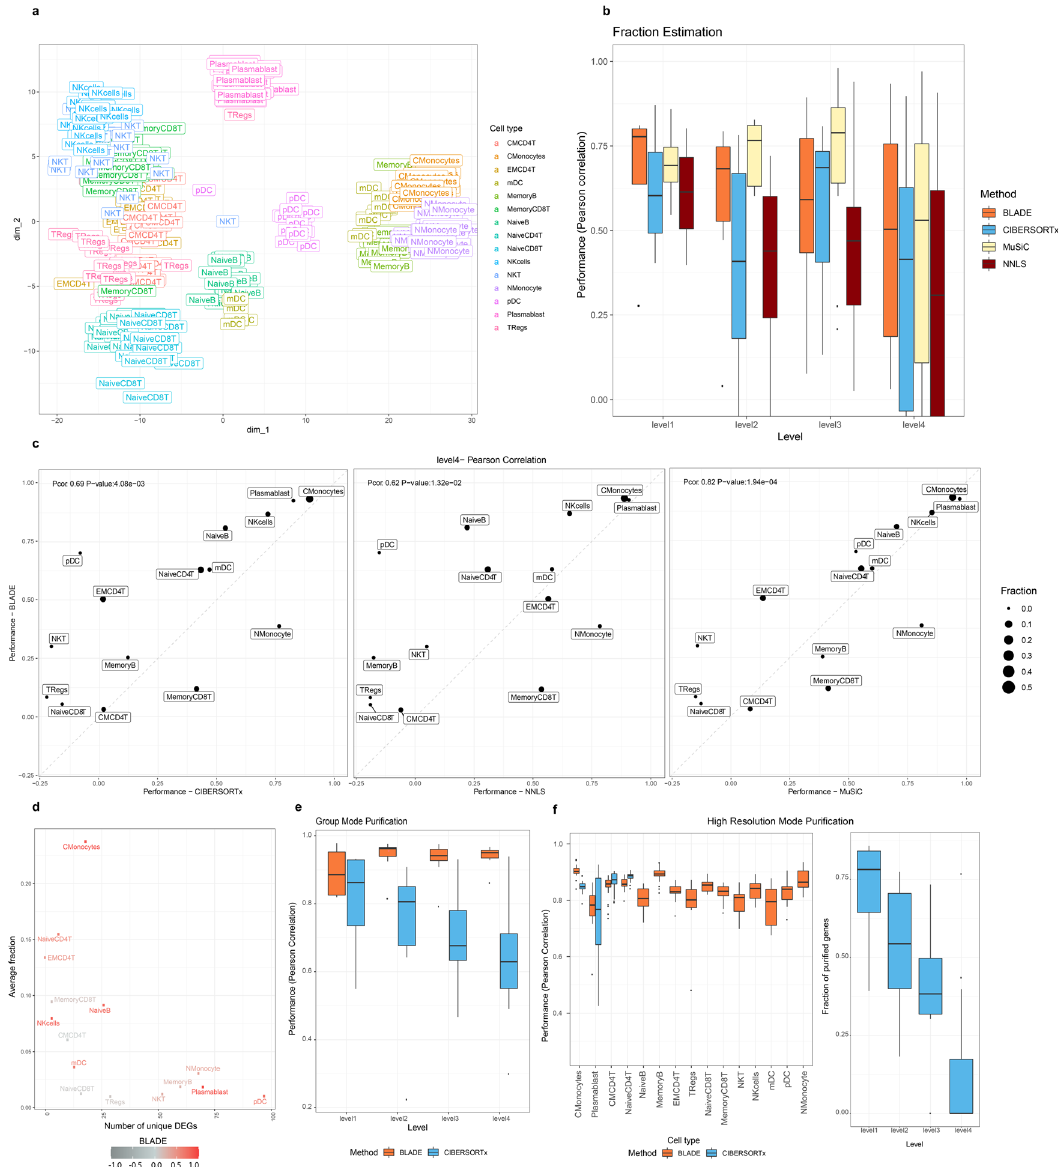
Fig. 5 Performance evaluation of BLADE using simulated PBMC bulk RNA-seq data. a A t-SNE plot represents the similarities in Pearson correlation coef fi cients among gene expression pro fi les of 15 cell types* (denoted by label) in 20 simulated bulk PBMC data. b Performances (Pearson correlation coef fi cient; y -axis) of BLADE (orange), CIBERSORTx (blue), NNLS (dark red), and MuSiC (light yellow) in predicting cellular fractions of the 20 simulated PBMC bulk RNA-seq data with diverse levels ( n = 4, 7, 12, and 15 cell types, respectively, in levels 1 – 4; x -axis). The standard boxplot notation was used (lower/upper hinges — fi rst/third quartiles; whiskers extend from the hinges to the largest/lowest values no further than 1.5 * inter-quartile ranges). c Comparison of performance in estimating the cellular fractions per cell type of BLADE ( y -axis) with CIBERSORTx, NNLS, and MuSiC ( x -axis) at level 4. The fraction of each cell type is indicated by the size of the point. Pearson correlation coef fi cient and two-tailed test P -values are indicated at the top left in each panel. d Performance of BLADE (indicated by color) and its association to the number of unique DEGs per cell type ( x -axis) and the respective fraction in the simulated data ( y -axis). e Performance in Pearson correlation coef fi cient of BLADE (orange), CIBERSORTx (blue) for group mode puri fi cation of four levels of PBMC simulation data ( n = 4, 7, 12, and 15 cell types, respectively, in levels 1 – 4; x -axis). The standard boxplot notation was used. f Performance (Pearson correlation coef fi cient; y -axis) of BLADE (orange) and CIBERSORTx (blue) in estimating gene expression pro fi les per cell type ( x -axis) and per sample in level 4 ( n = 20 samples per cell type; left). Fraction of genes in silico puri fi ed in high-resolution mode by CIBERSORTx at all levels of PBMC simulation data ( n = 20 samples with 4, 7, 12, and 15 cell types, respectively, in levels 1 – 4; x -axis; right). The standard boxplot notation was used. *(CMCD4T: central memory CD4 + T cell; CMonocytes: classical monocytes; EMCD4T: effector memory CD4 + T cell; mDC: myeloid dendritic cell; MemoryB: memory B cell; MemoryCD8T: memory CD8 + T cell; NaiveB: naive B cell; NaiveCD4T: naive CD4 + T cell; NaiveCD8T: naive CD8 + T cell; NKcells: natural killer cell; NKT: natural killer T cell; Nmonocyte: non-classical monocyte; pDC: plasmacytoid dendritic cell; TRegs: regulatory T cell).